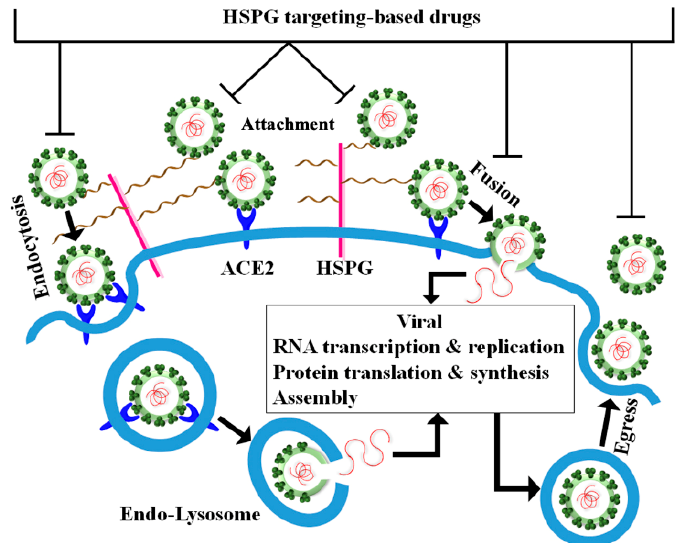
Figure 2. Schematics of the potential action of HSPG-targeting drugs in SARS-CoV-2 infection. HS binding compounds may compete with the viral particles for attachment to the HSPGs, thus inhibiting the viral engagement of HS chains and the subsequent access to the ACE2 receptor. Consequently, the viral entry by either fusion or endocytosis may be impaired. Table 3. HSPG-targeting therapeutics that might be useful against SARS-CoV-2